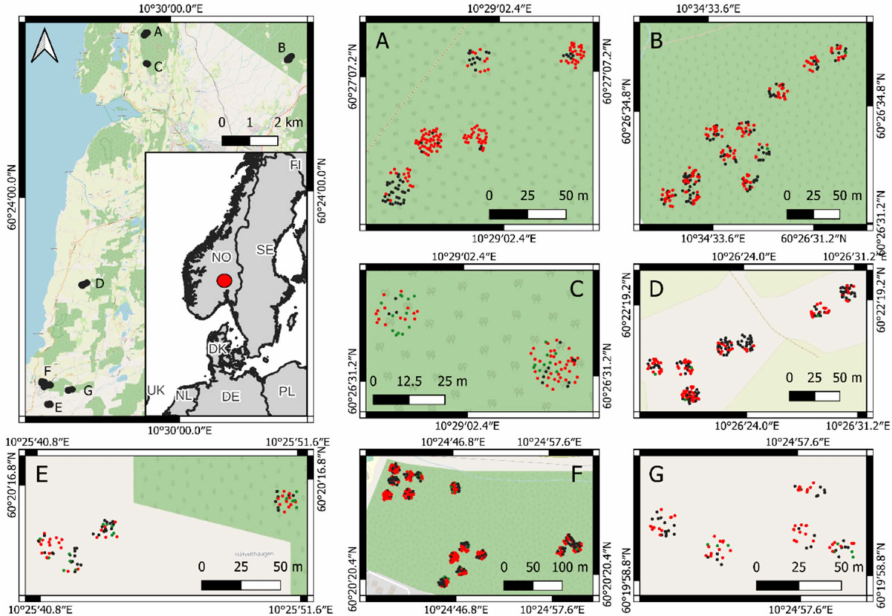
Figure 2. Dataset II: In the top left image: location of the field plots (black dots), and location of the study area in Norway (red dot). In the other images: location of the trees within the plots (red = healthy Norway spruce trees, black = wood decay-infected Norway spruce trees, green = other species) for the different locations ( A – G